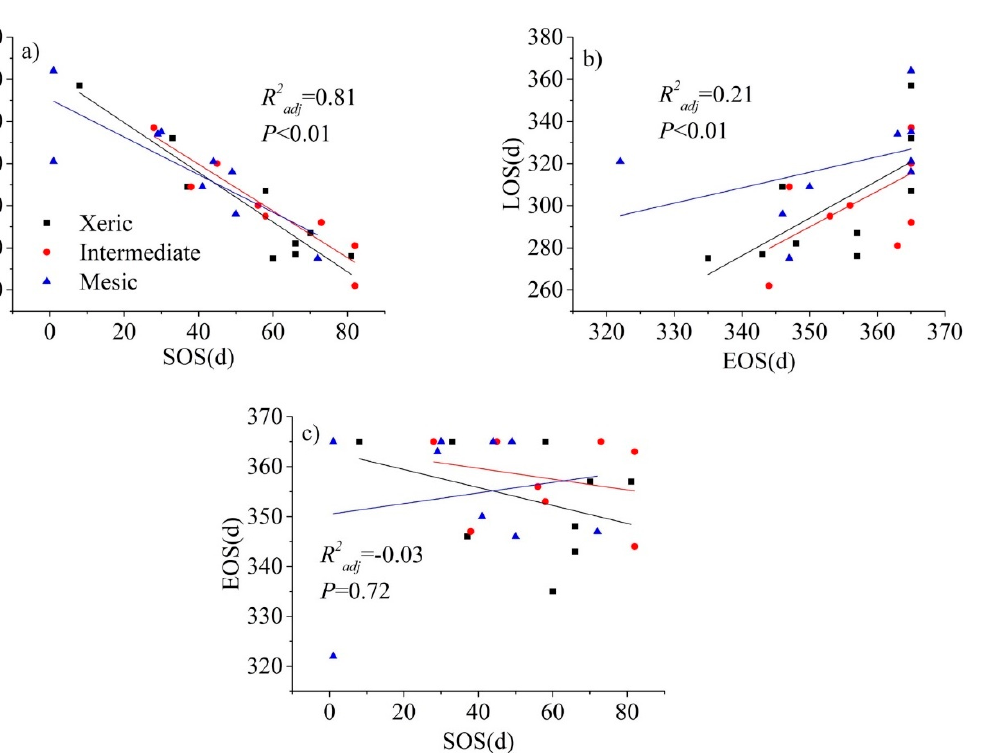
Anomalous response: AR; * fire year.